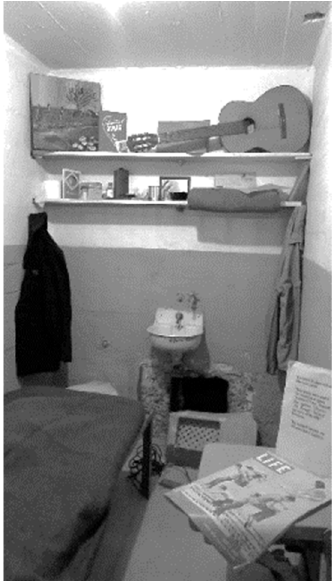
Figure 15. Personal belongings of inmates at the Ulucanlar Museum.